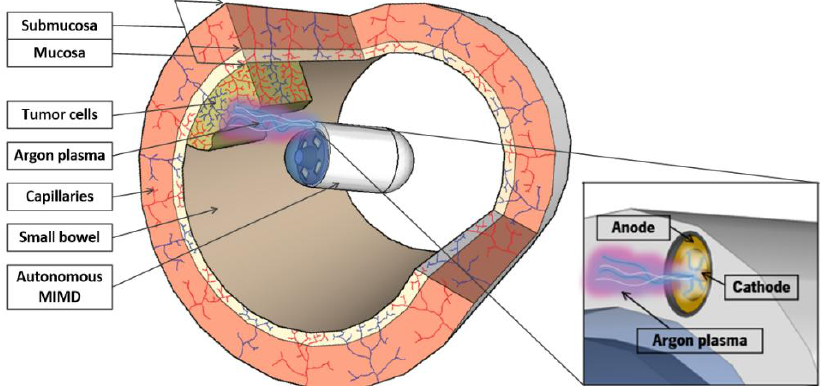
Figure 1. Illustration of the neutral argon plasma integrated in an autonomous minimally invasive medical device for therapy in small bowel (no access by traditional endoscopic